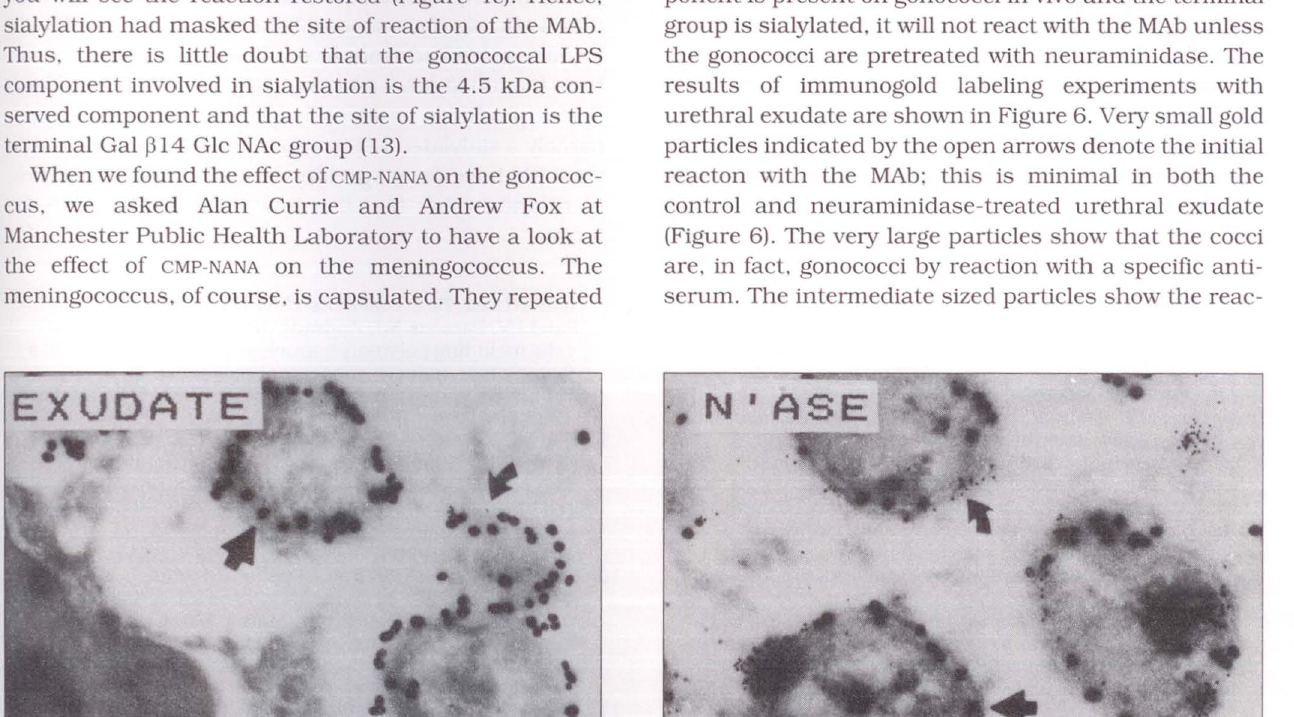
lion as gold particles are not visible (Figure 4b). If the CMP-NANA-treated organisms are. in tum, treated with neuraminidase and then again with lhe MAb followed